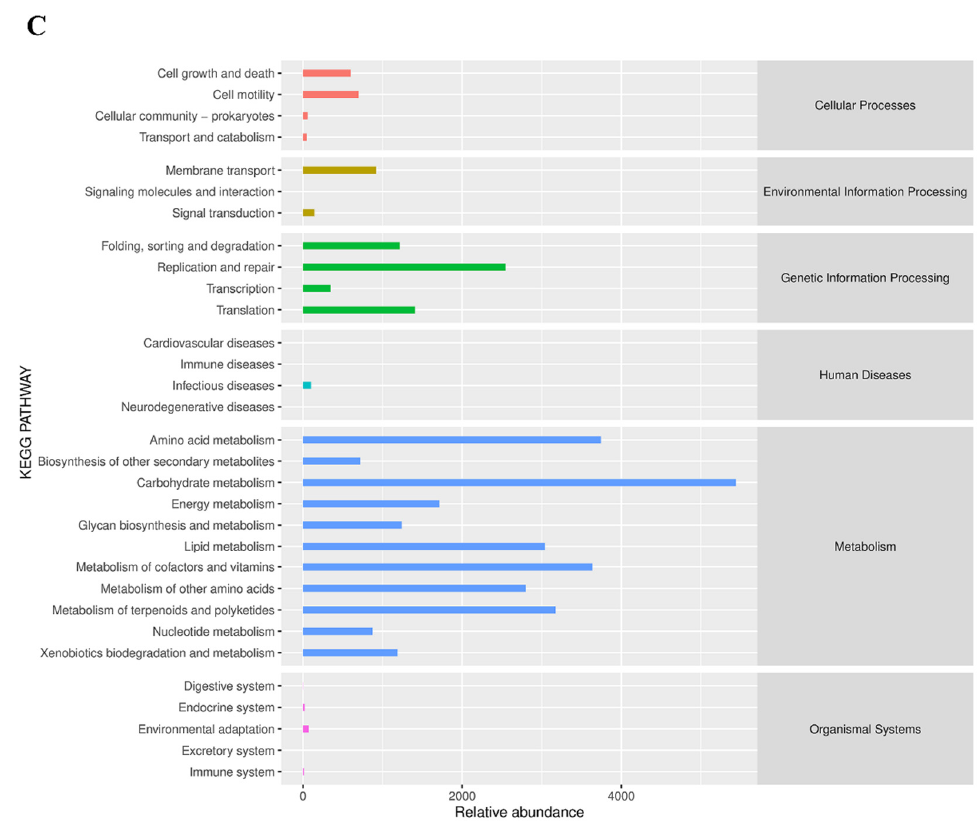
Figure 4. SCS regulates the composition of gut microbiota in colorectal cancer mice. Relative abundance map and difference analysis of the gut microbial composition at the genus level (LDA effect size > 2) (( A ); Differentially abundant taxonomic clades with a linear discriminant analysis (LDA) score >2.0 among cases with a p value < 0.05 ( B ); KEGG function annotation forecast ( C ).